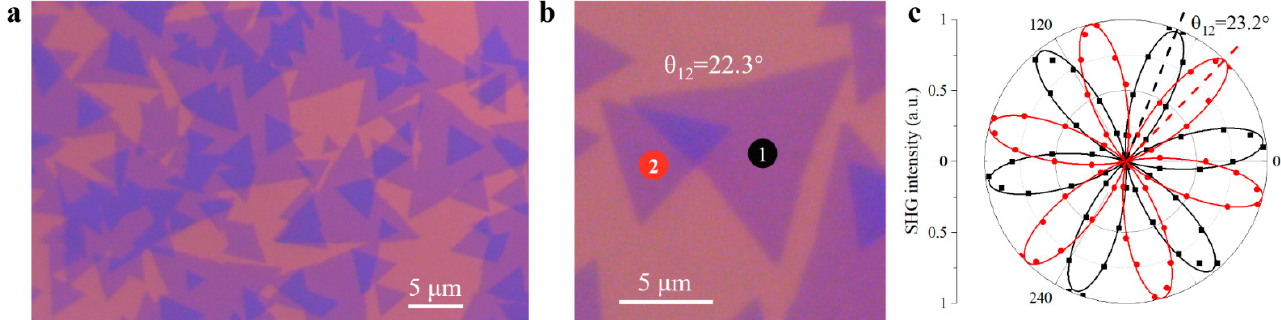
Figure 1. Characterization of twisted angle of MoS 2 bilayers. ( a ) Optical image of twisted MoS 2 bilayers. ( b ) Twisted angle of a bilayer sample, measured from optical image. ( c ) Twisted angle of bilayer sample in ( b ), determined by SHG measurements.